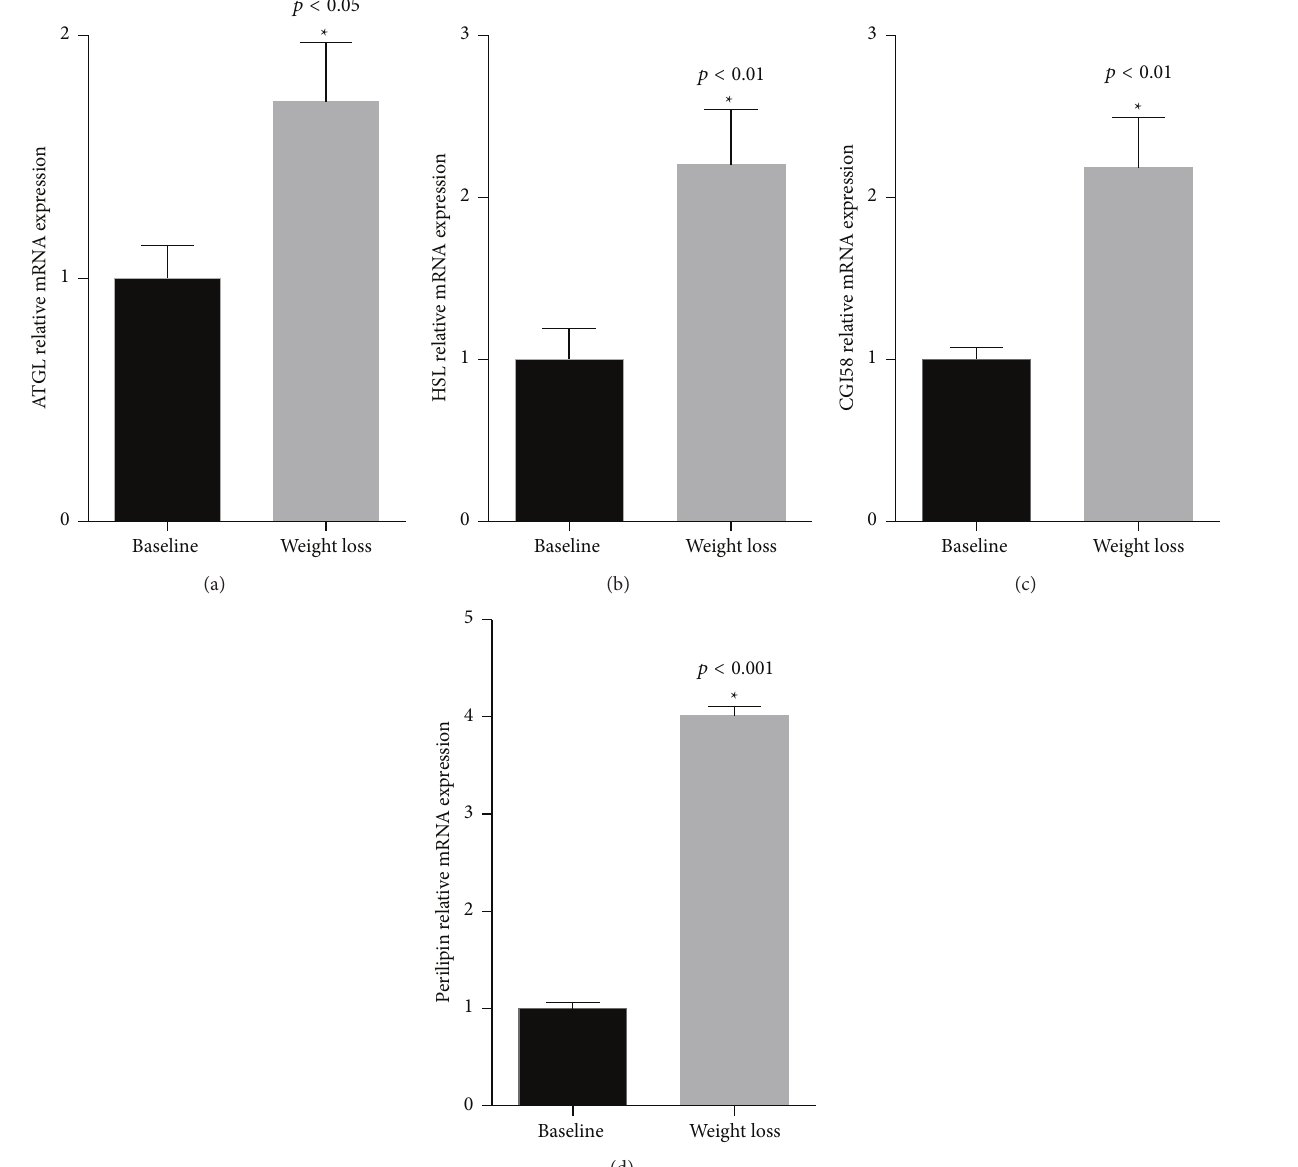
Figure 1: Lipolytic gene expression before and after bariatric surgery. Lipolytic gene mRNA for ATGL ((a), 𝑝 < 0.05 ), HSL ((b), 𝑝 < 0.01 ), CGI-58 ((c), 𝑝 < 0.01 ), and perilipin ((d), 𝑝 < 0.001 ) significantly increased in subcutaneous adipose tissue following bariatric surgery. Data are presented as relative expression, mean ± SEM, 𝑛 = 19